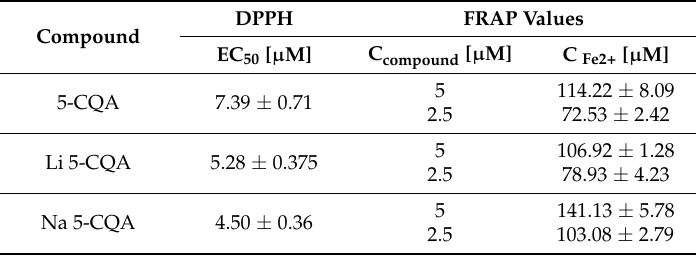
Table 4. Antioxidant properties of the chlorogenic acid, chlorogenates, trolox, L -ascorbic acid and BHT expressed as the ability to scavenge 50% of the free radical DPPH · ( α , α -diphenyl- β -picrylhydrazyl) (EC 50 ) and FRAP (ferric reducing antioxidant power) values (at concentrations 5 and 2.5 µ